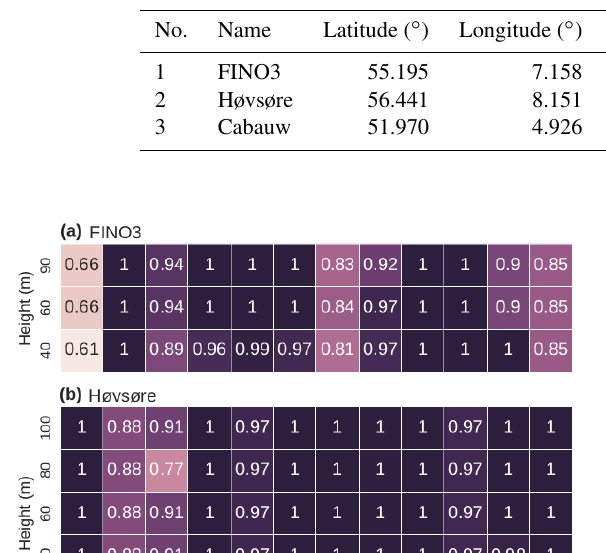
Table 1. Site description, including latitude and longitude coordinates, classification of the site, the height of the mast z s , and the location terrain elevation relative to sea-level z asl and prevailing wind direction.